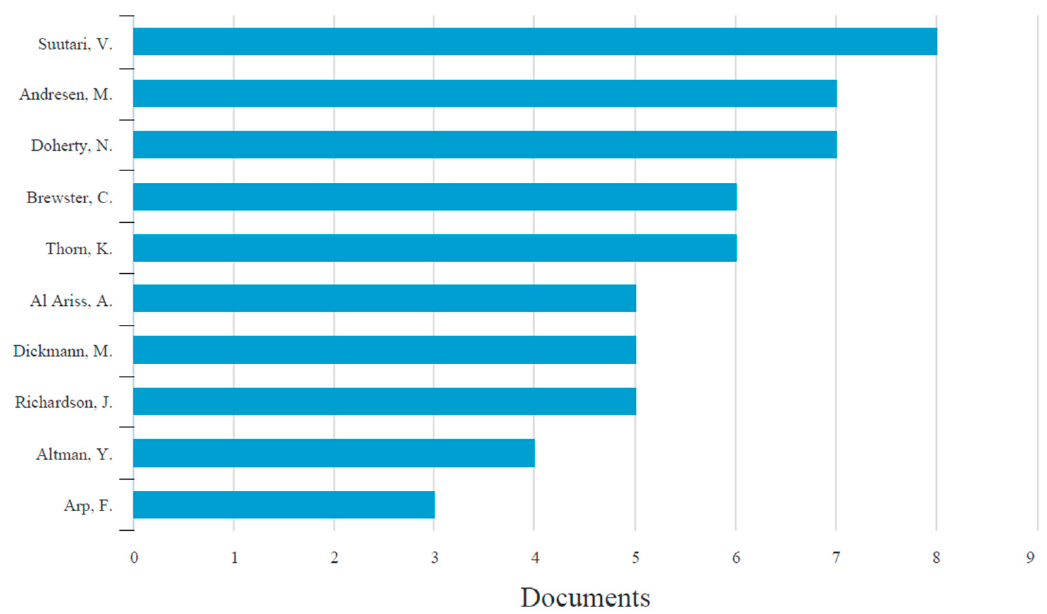
Figure 6. Self-initiated expatriation documents by author. Source: Data obtained from Scopus (August 2022).